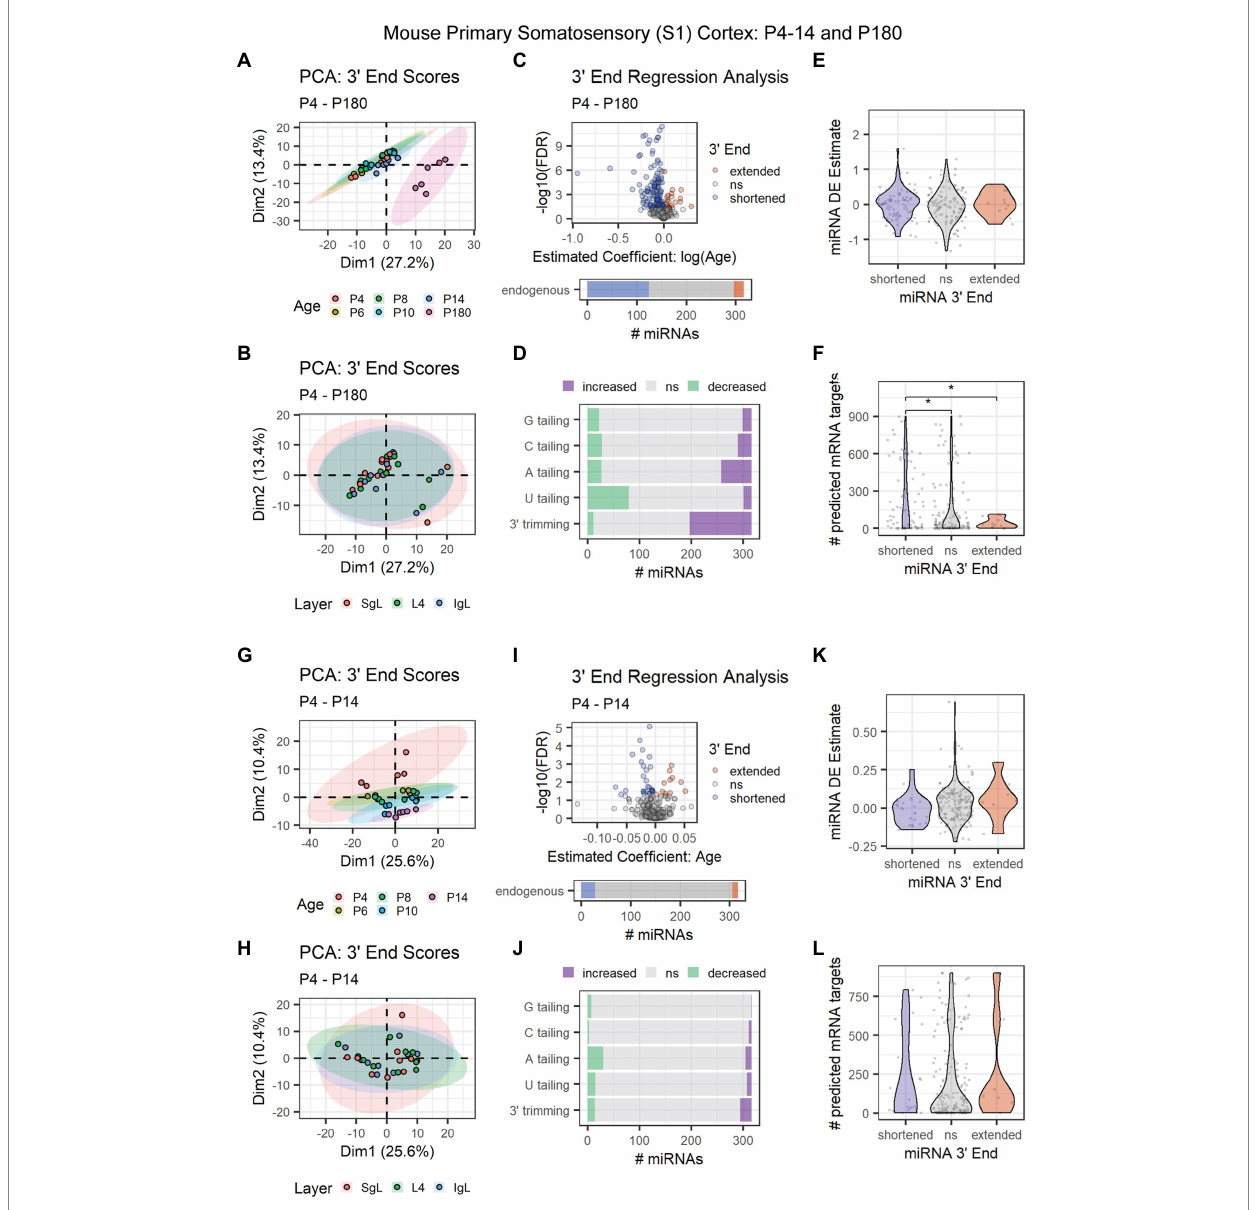
FIGURE 6 Age-associated 3 ′ shortening of miRNAs occurs in mouse S1 cortex between P14 and P180, but not between P4 and P14. (A–F) Data derived from P4, P6, P8, P10, P14, and P180 samples were included. For G-L, P180 samples were excluded. (A) PCA was performed on 3 ′ end scores derived from miRNA-seq data from P4-14 and P180 mouse S1 cortex. Samples clustered by age, with P180 samples clustering apart from earlier time points. Sample SRR1016226 was identified as an outlier and removed from downstream analyses (sample not shown). (B) PCA on 3 ′ end scores from P4–180 mice revealed no relationship with cortical layer in the first two dimensions. (C) 3 ′ ERA for mouse S1 cortex between P4 and P180. 124 of 316 miRNAs underwent 3 ′ shortening with age. (D) 3 ′ ERA by modification type revealed that 3 ′ shortening between P4 and P180 was primarily due to increased 3 ′ trimming and decreased U tailing. (E) Violin plot representing the relationship between miRNA 3 ′ end dynamics between P4 and P180 and the miRNA’s DE Estimate, which summarizes the change in miRNA levels with age. Positive DE Estimate values reflect miRNAs that increase with age, while negative values reflect miRNAs that decrease with age. Each point represents one miRNA. Kruskal-Wallis: p = 0.5. (F) Violin plot representing the relationship between miRNA 3 ′ end dynamics between P4 and P180 and the number of predicted mRNA targets detected for each miRNA. Each point represents one miRNA. Kruskal-Wallis: p = 0.011. Wilcox test for pairwise comparisons: * p < 0.01. (G) PCA was performed on 3 ′ end scores derived from miRNA-seq data from P4-14 mouse S1 cortex. Samples approximately clustered by age. (H) PCA on 3 ′ end scores from P4-14 mice revealed no relationship with cortical layer in the first two dimensions. (I) 3 ′ ERA for mouse S1 cortex between P4 and P14. Only 28 of 316 miRNAs underwent 3 ′ shortening with age. (J) 3 ′ ERA by modification type revealed that increased A tailing was the single largest contributor to 3 ′ end dynamics between P4 and P14. (K) Violin plot representing the relationship between miRNA 3 ′ end dynamics between P4 and P14 and the miRNA’s DE Estimate, which summarizes the change in miRNA levels with age. Positive DE Estimate values reflect miRNAs that increase with age, while negative values reflect miRNAs that decrease with age. Each point represents one miRNA. Kruskal-Wallis: p = 0.13. (L) Violin plot representing the relationship between miRNA 3 ′ end dynamics between P4 and P14 and the number of predicted mRNA targets detected for each miRNA. Each point represents one miRNA. Kruskal-Wallis: p = 0.51. See Supplementary Figure S9 for analysis of P4-14 miRNA and mRNA count data and target